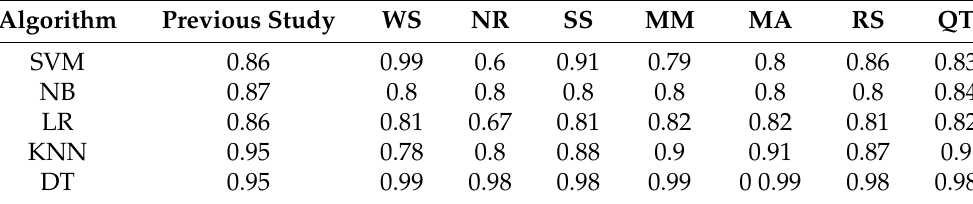
Table 15. Comparison of Precision with previous study conducted by Amin et al. (2019) [21].